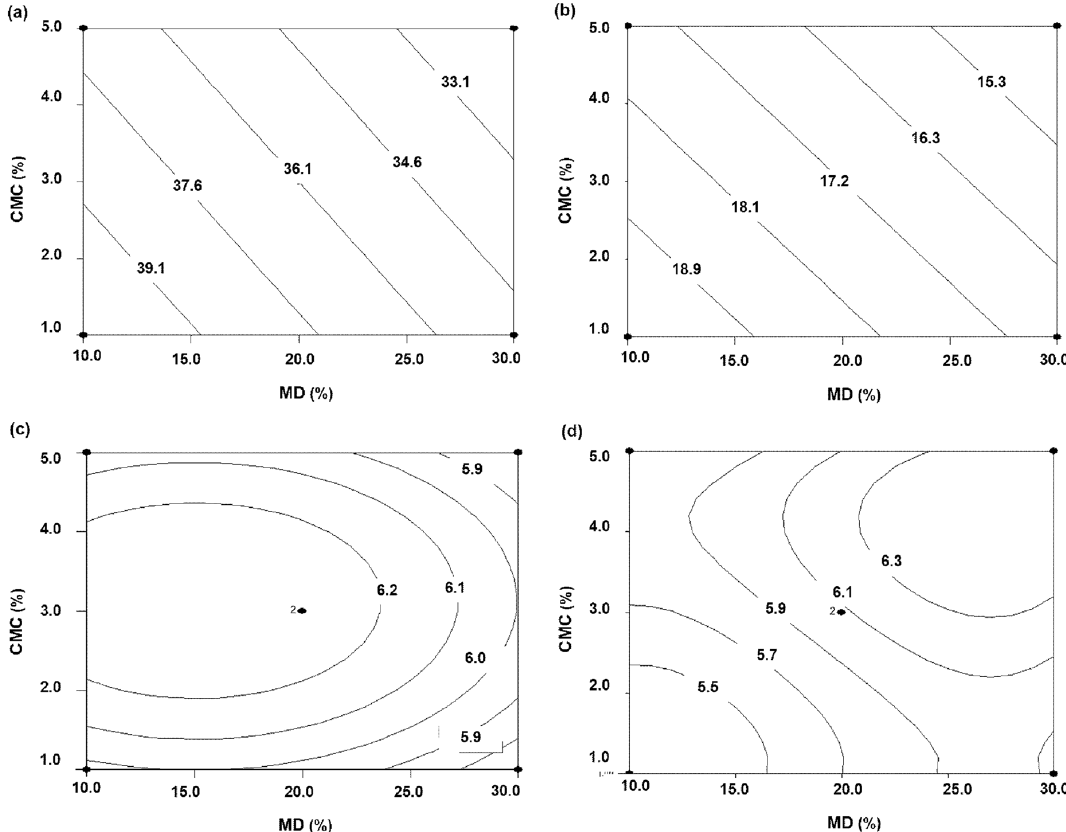
Figure 2. Contour plots of the effect of the interaction between MD and CMC on texture and sensory attributes; hardness ( a ), gumminess ( b ), appearance ( c ), and colour ( d ).